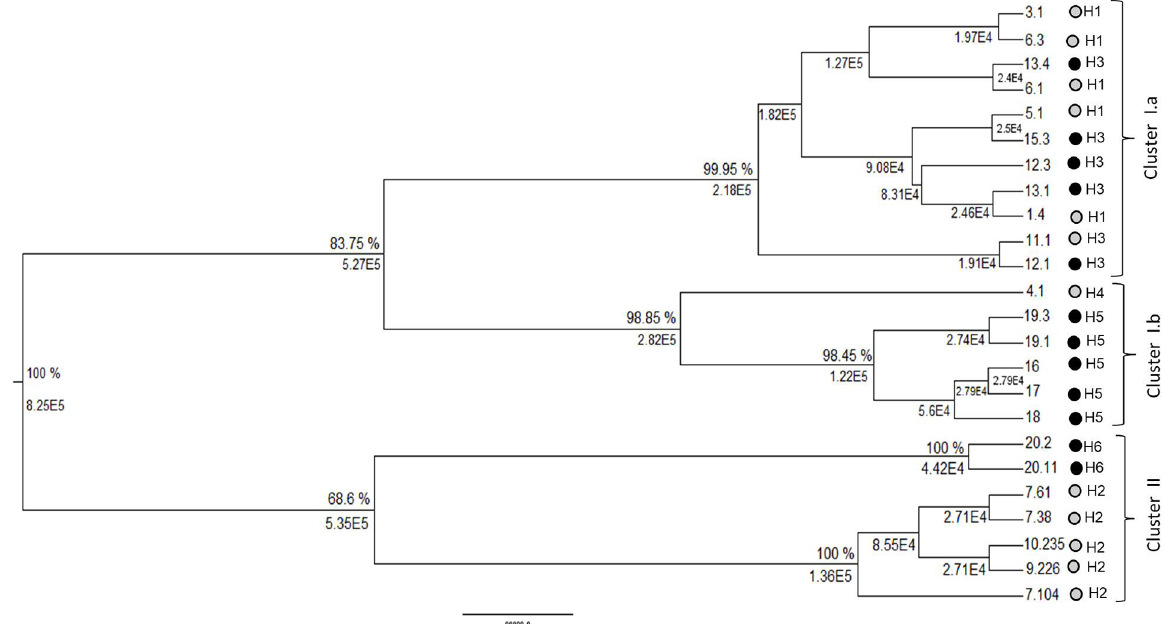
Figure 9. Bayesian inference tree of Turnera sidoides subsp. carnea based on two plastid DNA intergenic sequences. Posterior probabilities > 50 % are indicated at the beginning of each node. Numbers forward each node show estimates for the ages. Dark and grey circles represent individuals assigned to the grandense and mercedeño morphotypes, respectively. The haplotype found in each individual is pointed to the